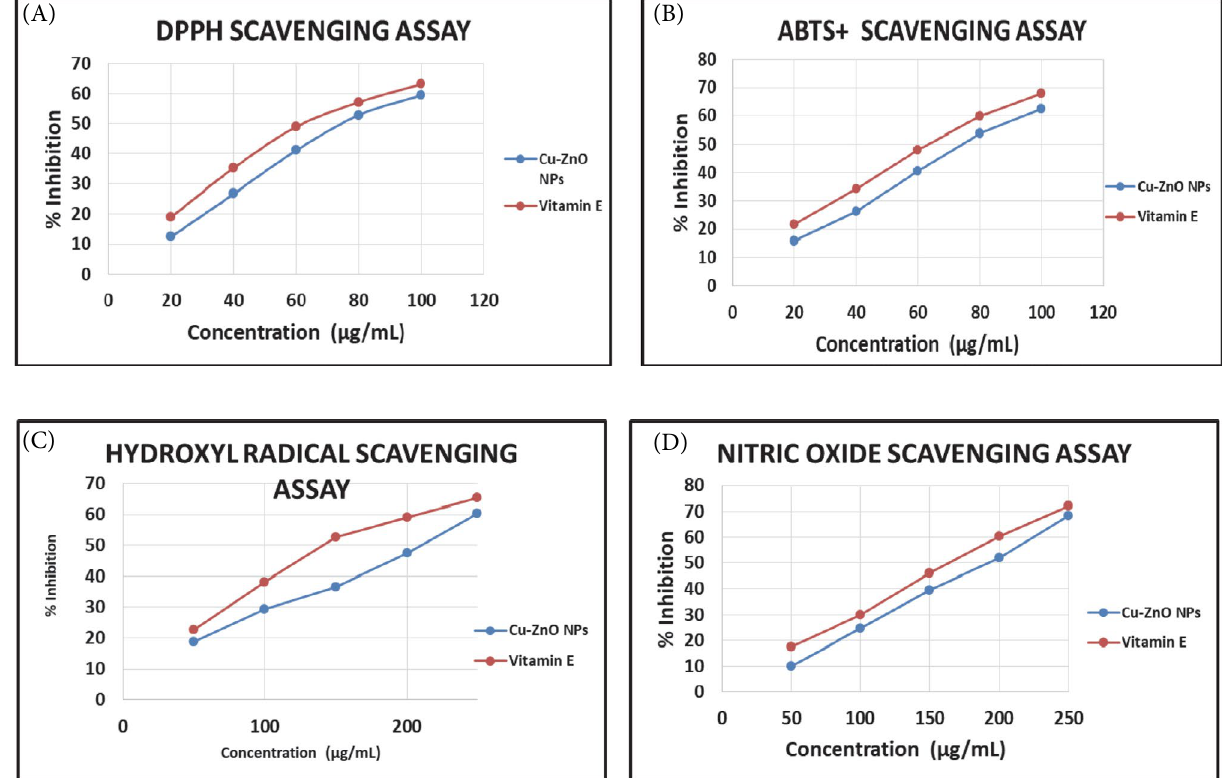
Figure 8. (A) DPPH, (B) ABTS + , (C) · OH, (D) NO· radical scavenging activities of Cu-ZnO NPs and standard at various